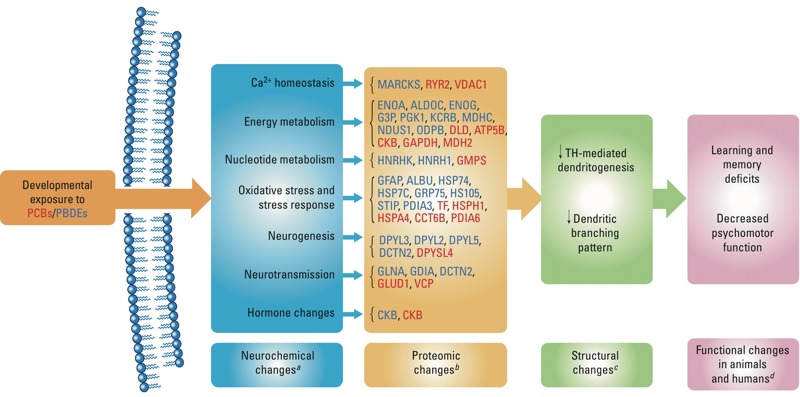
Schematic showing possible adverse outcome pathways for the developmental neurotoxicity of PCBs/PBDEs using a systems biology approach. The schematic highlights the pathways that link PCB/PBDE exposure to neurochemical changes and genomic and proteomic changes that may lead to structural and functional changes. Proteins listed in red were altered by developmental exposure to PCB; those listed in blue were altered by developmental PBDE exposure. Although different proteins were altered by these structurally related chemicals (PBDEs and PCBs), it is very interesting to note that similar pathways were altered by the developmental exposure and hence may have a common mode of action for the adverse effects associated with these chemicals.
aData from Kodavanti et al. (2005, 2010). bData from the present study and Kodavanti et al. (2011). cData from Ibhazehiebo et al. (2011). dData from Eriksson et al. (2001), Eskenazi et al. (2013), Herbstman et al. (2010), and Rice et al. (2007).